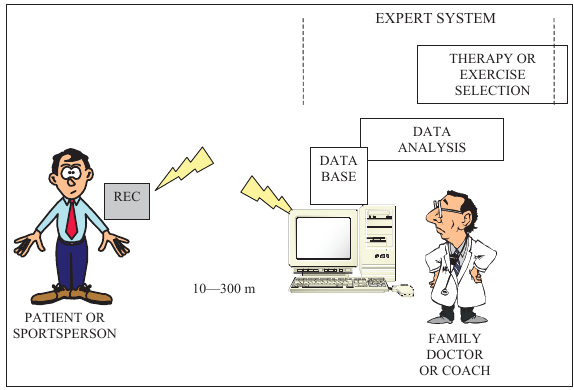
Figure 1. The architecture of ECG and motion activity monito- ring system